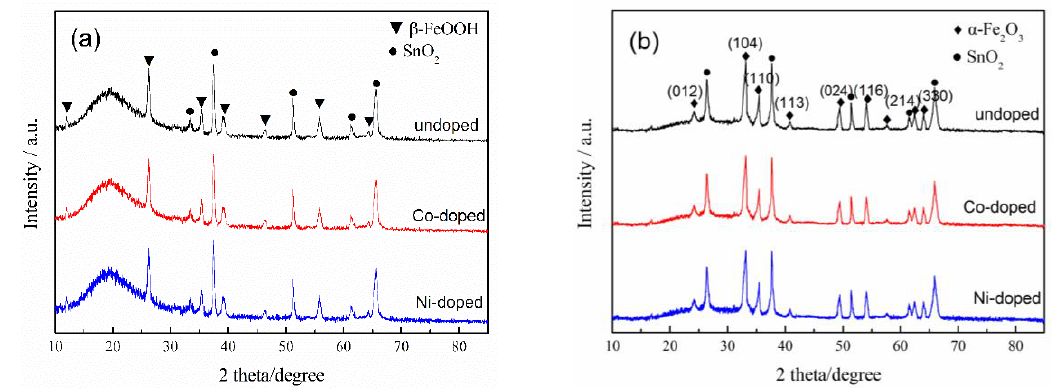
Figure 3. X-ray diffraction (XRD) profiles of the samples prepared by aqueous chemical growth: ( a ) before annealing; ( b ) after annealing, the (h k l) values of α-Fe 2 O 3 are marked.